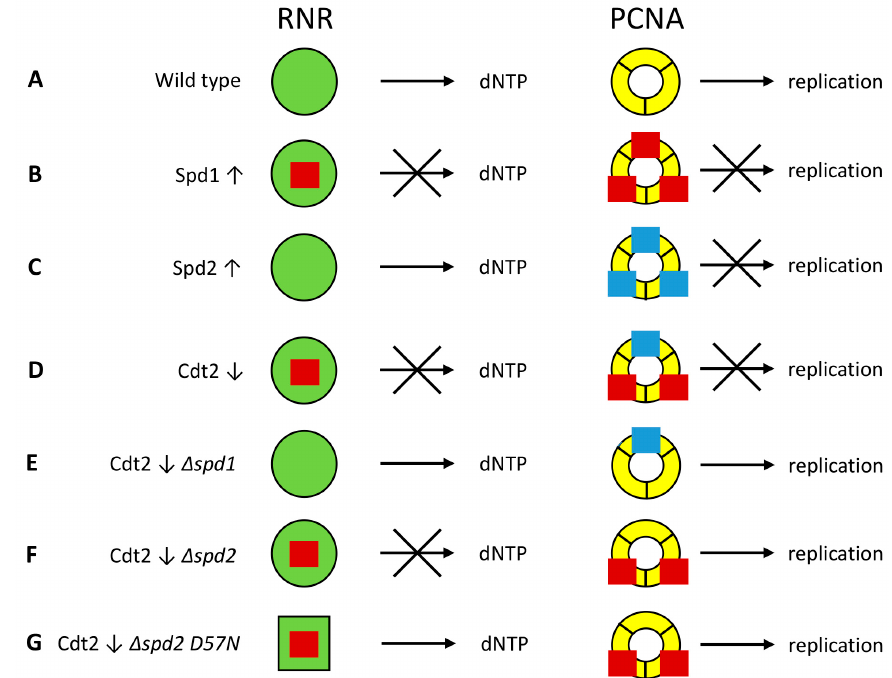
Figure 6. Model for inhibition of DNA replication by Spd1 and Spd2. Spd1 (red squares) can inhibit ribonucleotide reductase (RNR, green circles), while both Spd1 and Spd2 (blue squares) can inhibit replication by binding to proliferating cell nuclear antigen (PCNA, yellow rings). S phase is inhibited if at least one of these two events occurs. ( A ) In wild type cells, both Spd1 and Spd2 are degraded, and hence dNTP production and elongation are not inhibited. ( B ) When Spd1 is overexpressed ( ↑ ), it inhibits both processes. ( C ) In cells overexpressing Spd2, only PCNA is inhibited. ( D ) In Cdt2 depleted cells ( ↓ ), Spd1 and Spd2 accumulate to a moderate level. Spd1 inhibits RNR, while both Spd1 and Spd2 are required to raise the concentration to a level where inhibition of PCNA can occur. ( E ) Deletion of spd1 relieves both types of repression. ( F ) When spd2 is deleted in Cdt2-depleted cells, repression of PCNA is lifted, but Spd1 still inhibits RNR. ( G ) The cdc22-D57N mutation changes the RNR configuration (green square) so that it can no longer be inhibited by dATP through negative feedback. Hence, sufficient amounts of dNTPs are formed even in the presence of Spd1 inhibition.